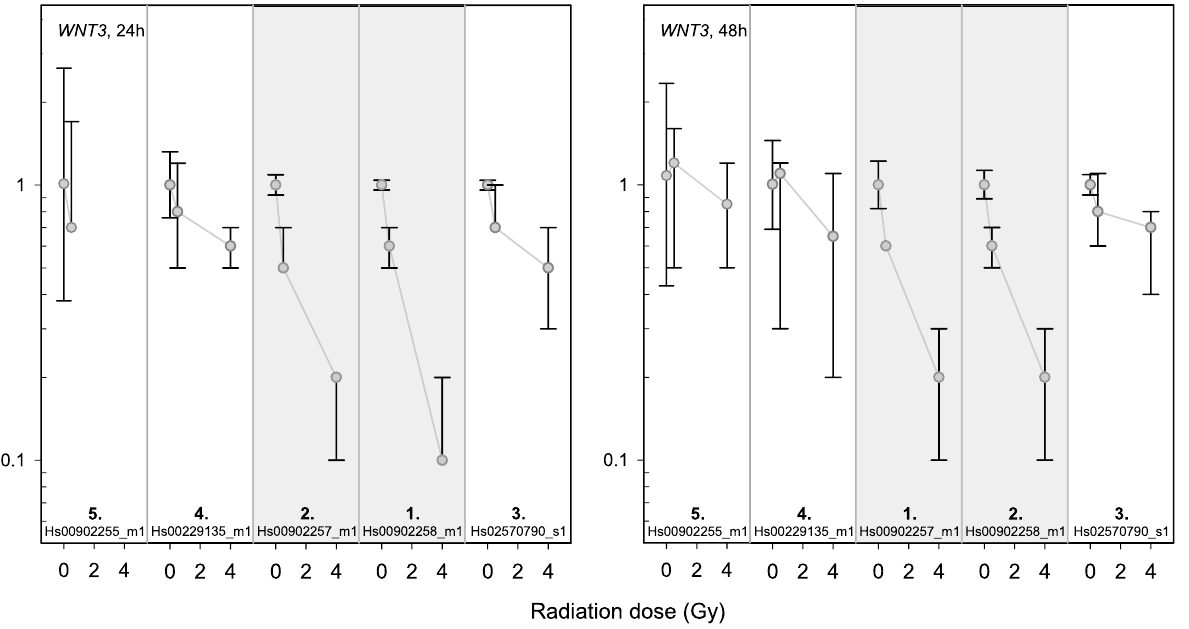
Figure 7. Inter-individual variability of WNT3 TaqMan assays. Plotted is the differential gene expression relative to unexposed of WNT3 for each assay after 24 h (left panel) and 48 h (right panel). The symbol represents the median, and the lower and upper whiskers represent the minimum and maximum fold change, respectively. Additionally, symbols are connected with simple straight lines for each TaqMan assay. After summing up the standard deviations of radiation dose, ranks were assigned. 1st rank is the lowest inter- individual variability, 5th rank is the highest. The two assays highlighted in gray are those most suitable for biodosimetry as identified in Fig. 6 using other criteria (baseline, dose dependency, time